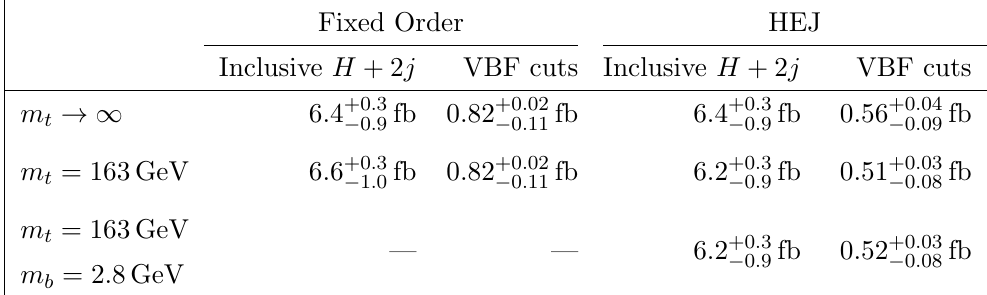
r = (cid:22) f = H T = 2 and di(cid:11)erent